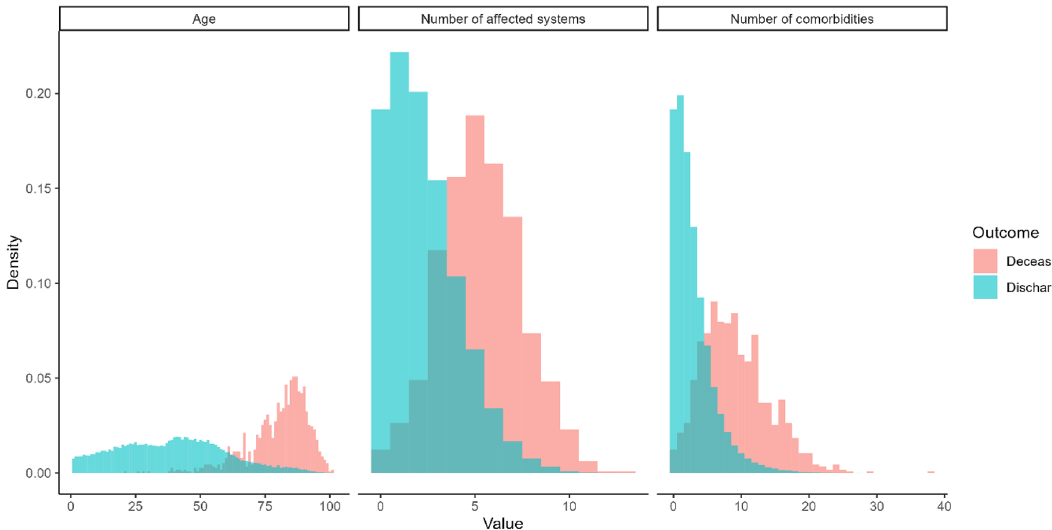
Figure 2. Feature distribution. Distribution of age, the number of affected systems, and the number of comorbidities regarding the final patient outcome. We clearly see different distributions of these variables between discharge and deceased patients.